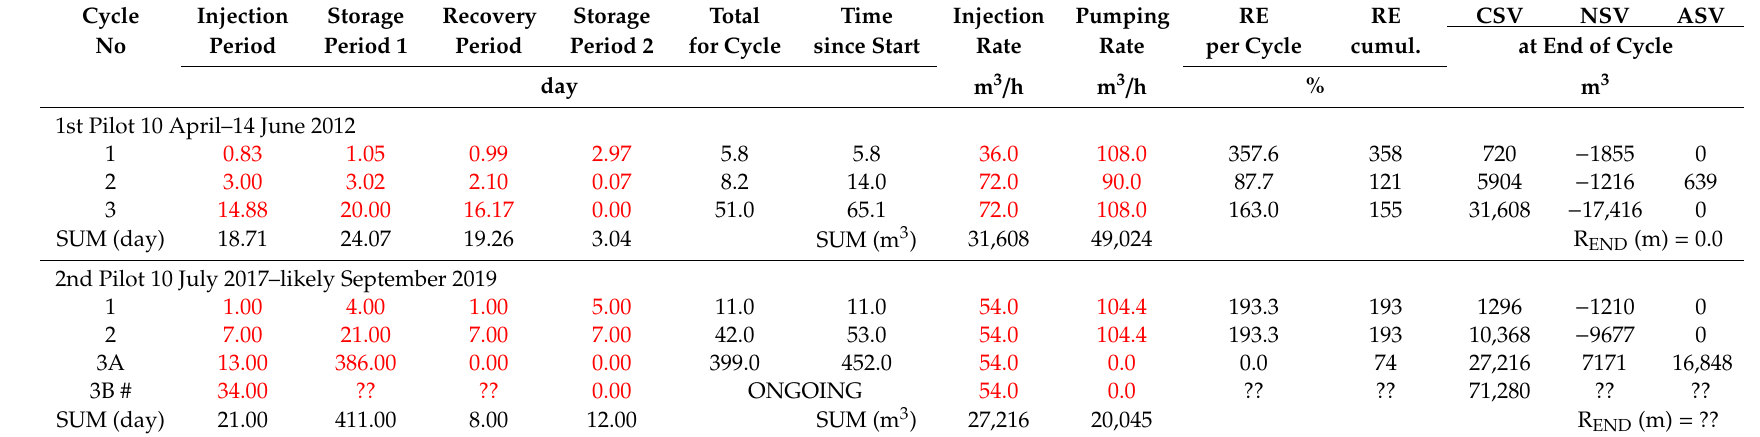
Table 1. Details of ASR cycling scheme during the first and second pilot. CSV = cumulative stored volume; NSV = net stored volume (injected minus recovered);